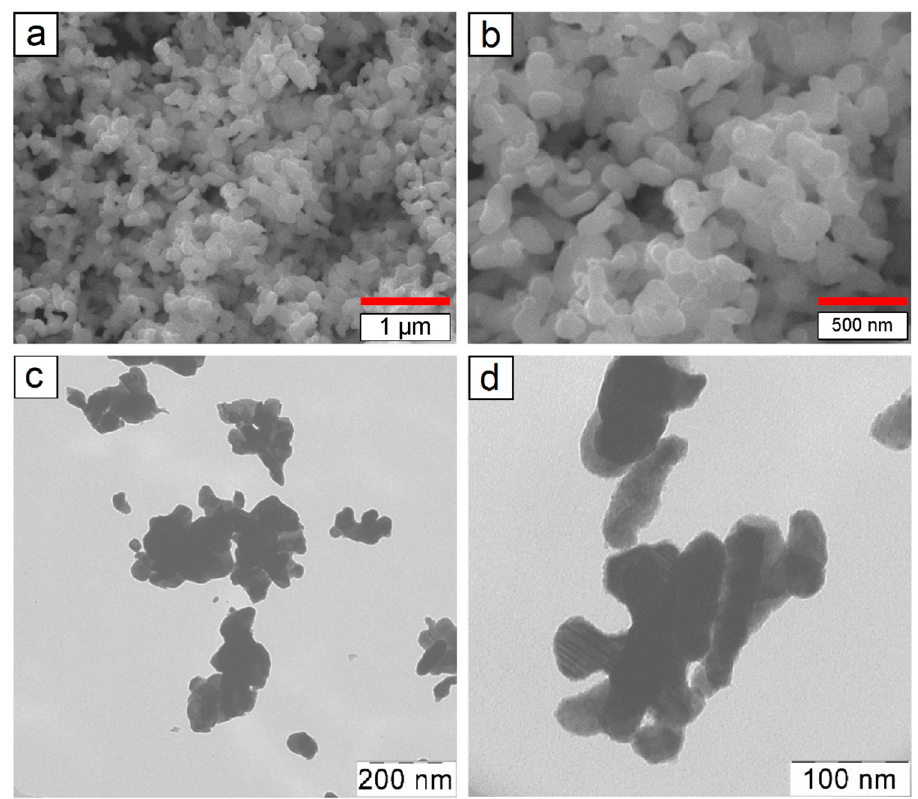
Figure 2. ( a, b ) SEM and ( c, d ) TEM micrographs of synthesized Co nanopowders. Figure 2. ( a , b ) SEM and ( c , d ) TEM micrographs of synthesized Co